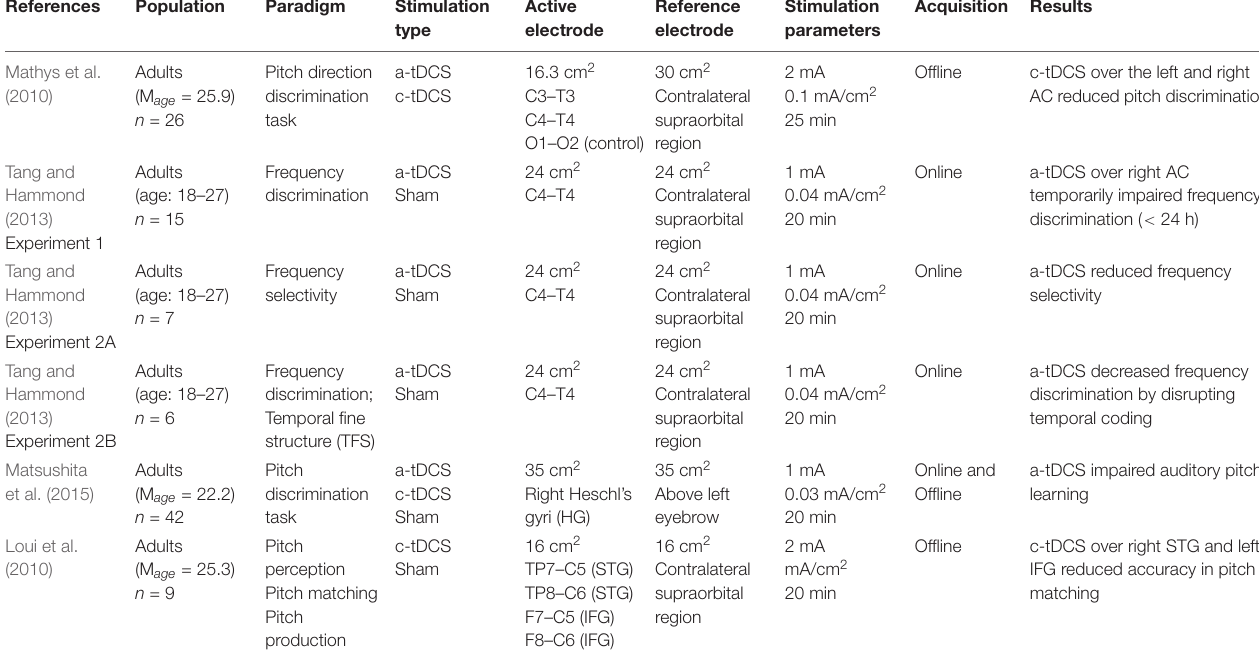
TABLE 3 | Spectral processing.